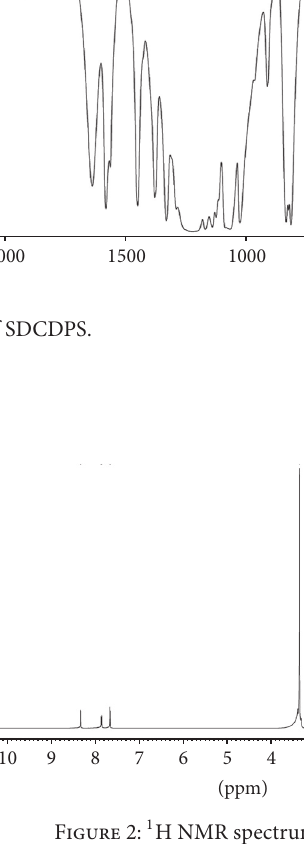
Figure 2: 1 H NMR spectrum of